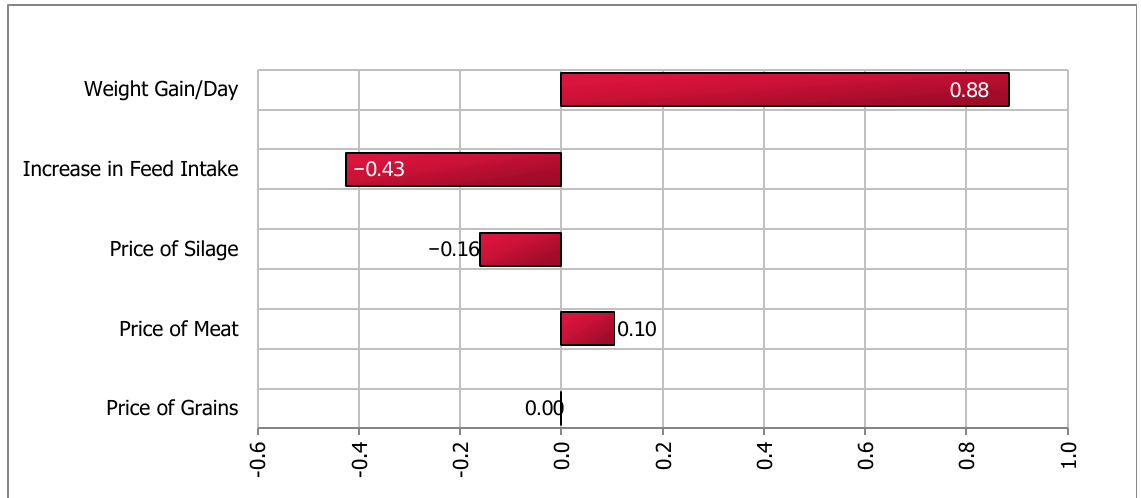
Figure 4. Tornado plot of regression coefficients for determinants of a change in net income under increased space allowance (from 2.2 to 2.7 m 2 /calf)—Scenario 2b.